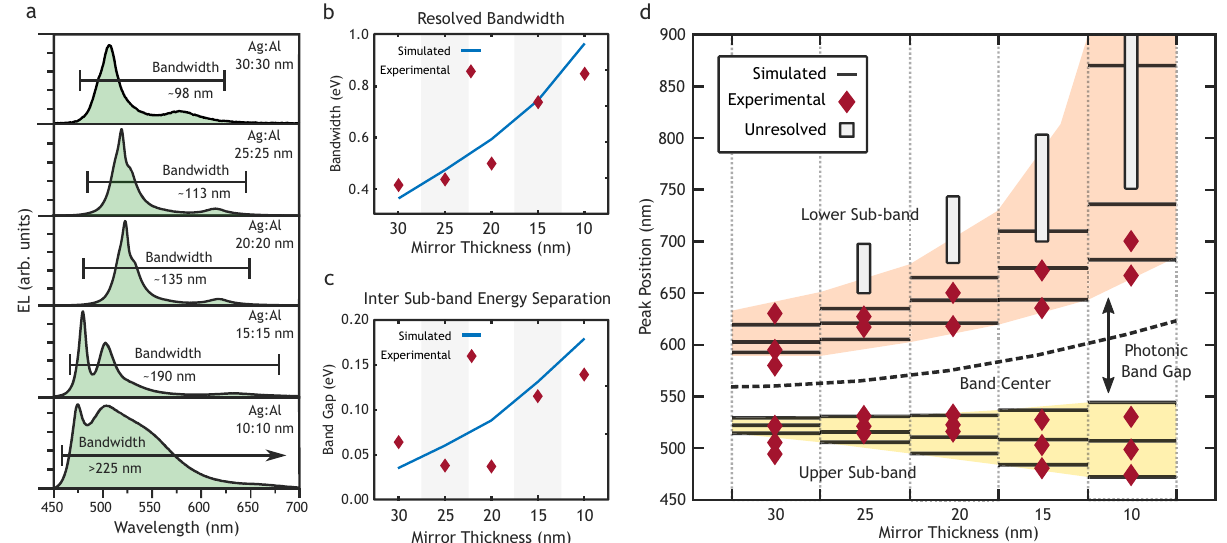
Fig. 3 Modulation of the density of states through decreasing mirror thickness. a Experimental emission spectra of six-cavity stacked OLED devices with mirror thickness of d = 30 → 10 nm. b Bandwidth of the resolved peaks as measured between the highest energy state to the fi rst harmonic (second lowest). The fundamental mode of the crystal was not experimentally resolvable for d < 30 nm and was omitted for the bandwidth calculation. c Average energy separation between states in the upper sub-band. Energy separation increases with decreasing d due decreased perturbation of the extended cavity states. d Comparison of experimentally observed and simulated peak locations for d = 30 → 10 nm. Decreasing d is shown to result in a lower density of states through an increase in the photonic band-gap and the separation between